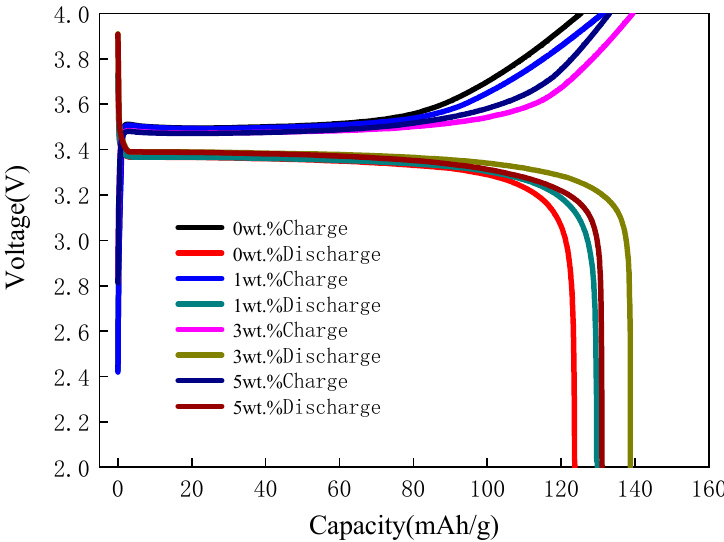
Figure 5. Initial charge/discharge capacity comparison of LFP/C-xZnO (x = 0, 1 wt%, 3 wt%, 5 wt%) at 0.1 C.